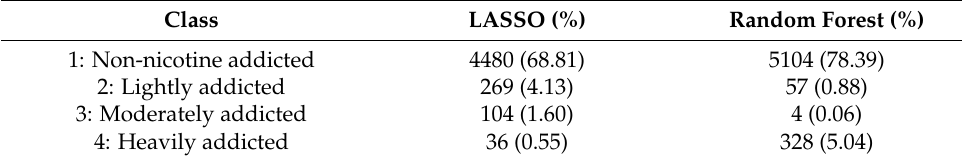
Table 3. Comparison of accuracy based on Confusion Matrices (N =